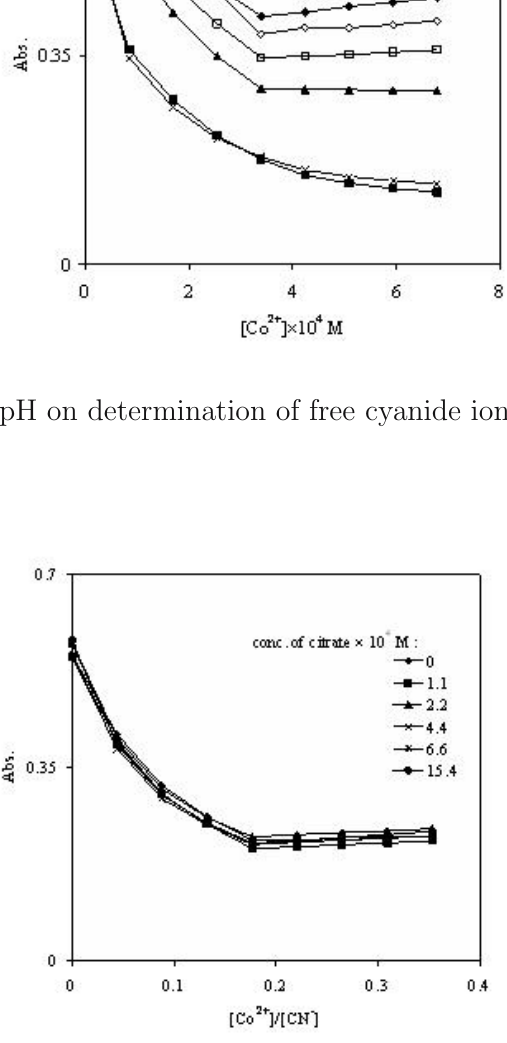
Fig. 4 Effect of concentration of trisodium citrate on titration curves: titration of CN − (2 × 10 − 3 M) with Co 2+ (1 . 7 × 10 − 3 M) in the presence of citrate (0 − 15 . 4) × 10 − 4 M, pH